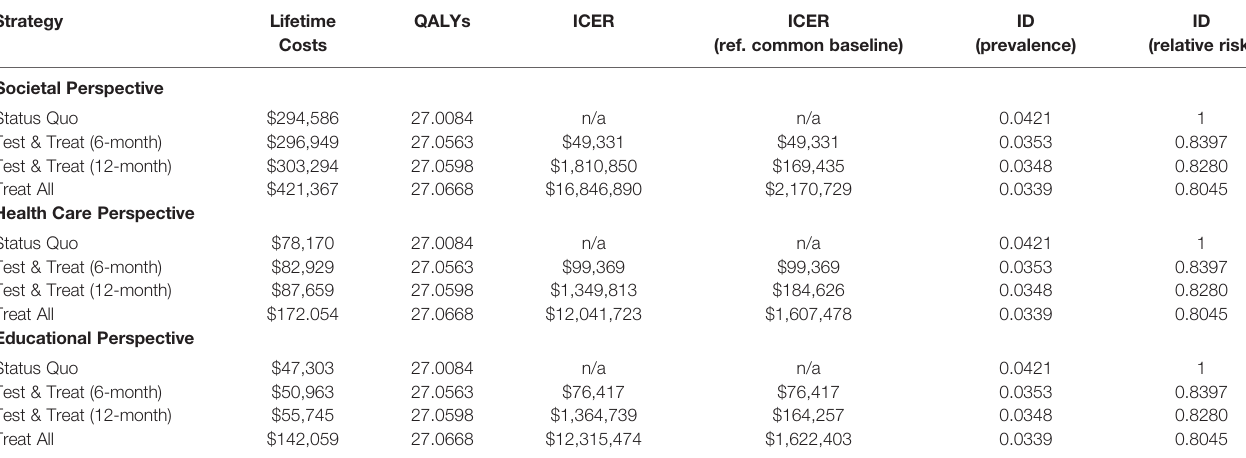
TABLE 2 | Cost-effectiveness